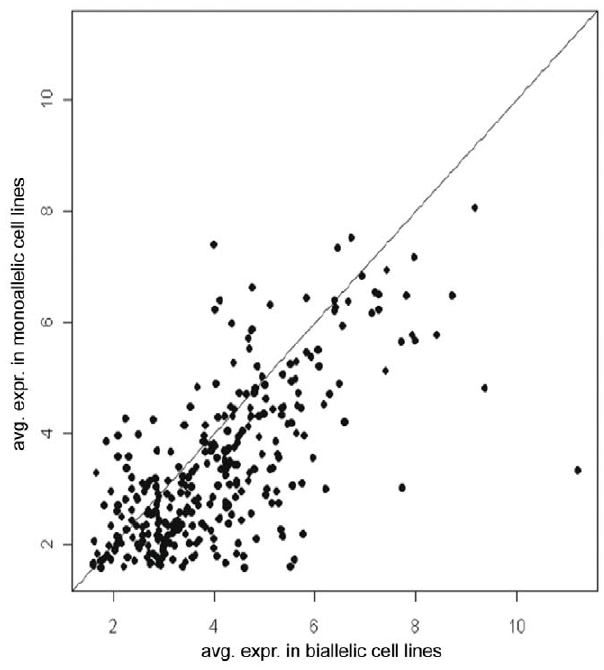
Figure 3. Expression levels vs. monoallelic or biallelic expres- sion. Results are plotted for 313 genes that show monoallelic expression in some NSC lines and biallelic expression in others. For each gene the average log2(RPKM) in NSC lines with monoallelic expression (y-axis) is plotted vs. the log2(RPKM) in cell lines with biallelic expression.